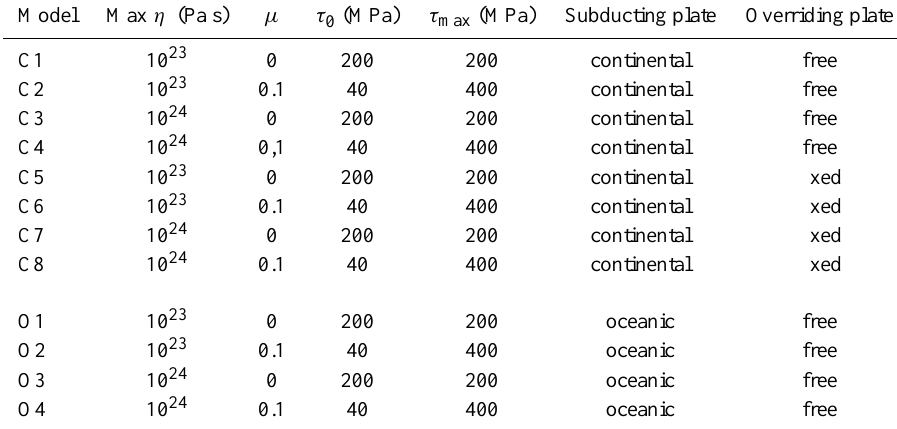
Table 2. Summary of the models used in this parametric